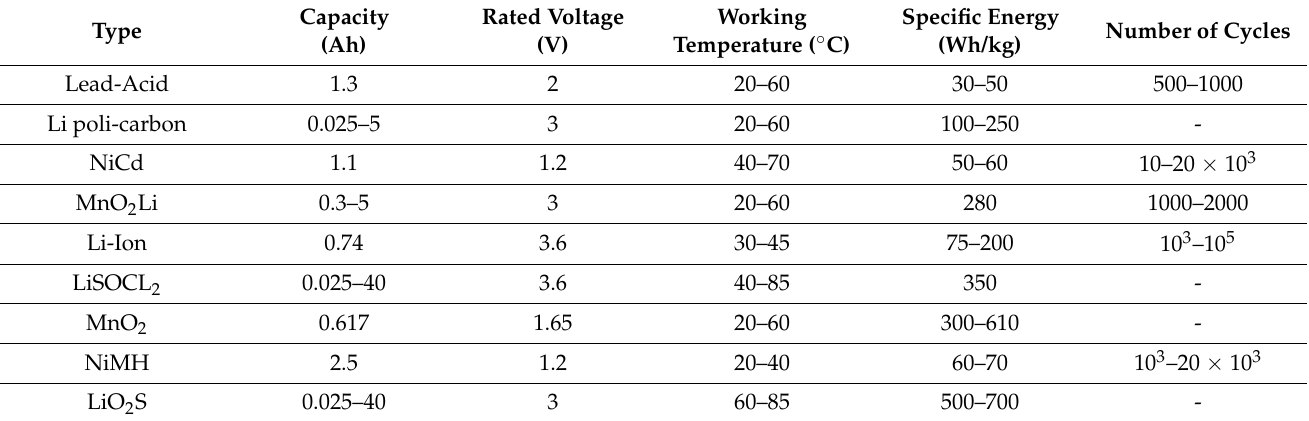
Table 1. Efficiency of electricity sources used to power end devices in IoT networks.